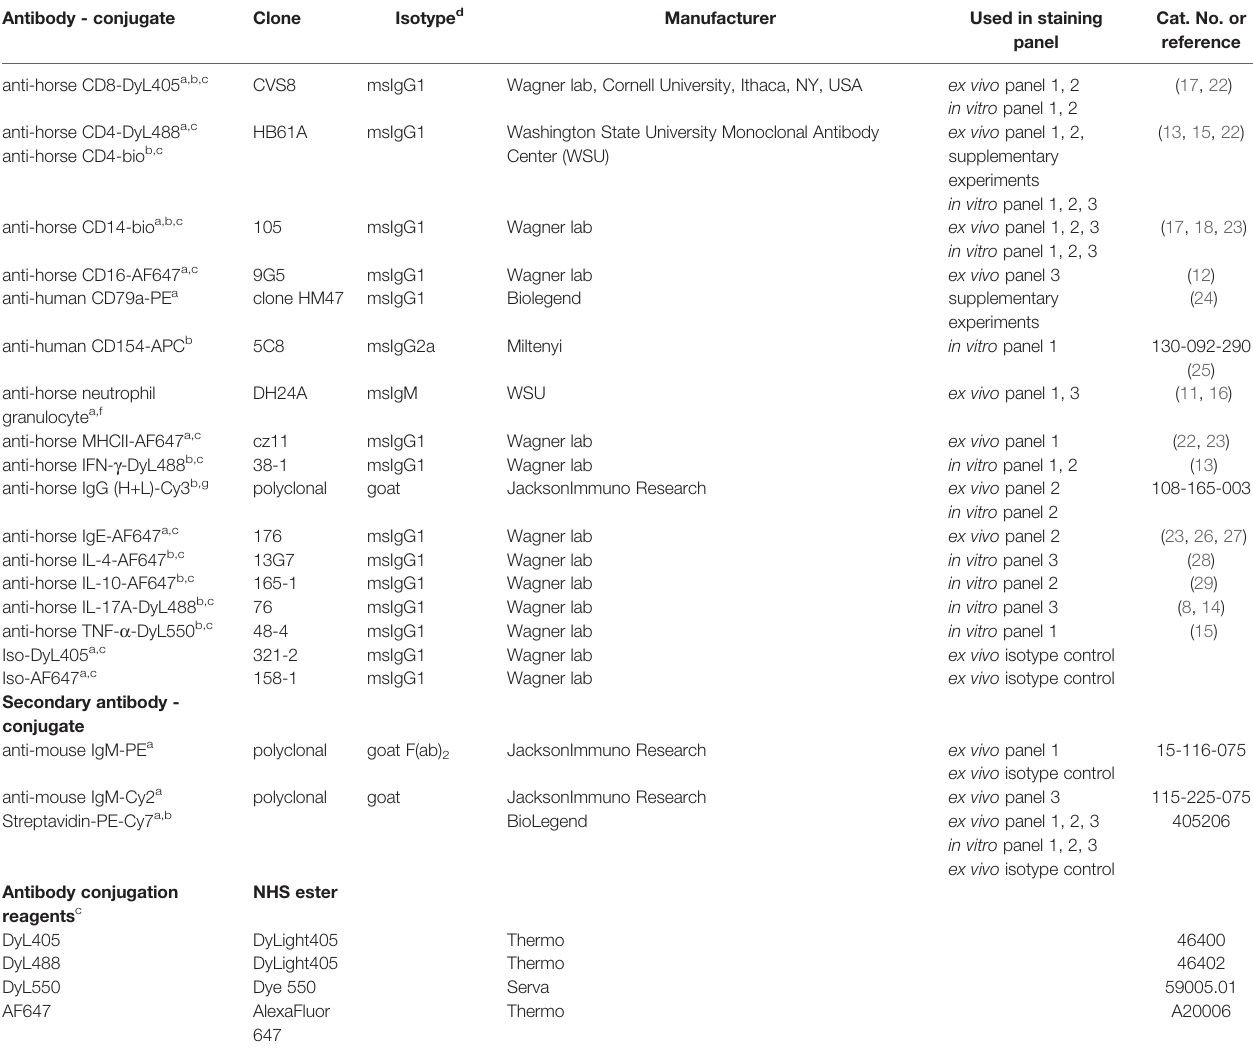
TABLE 2 | Antibodies and fl uorochrome labelling reagents for fl ow cytometric